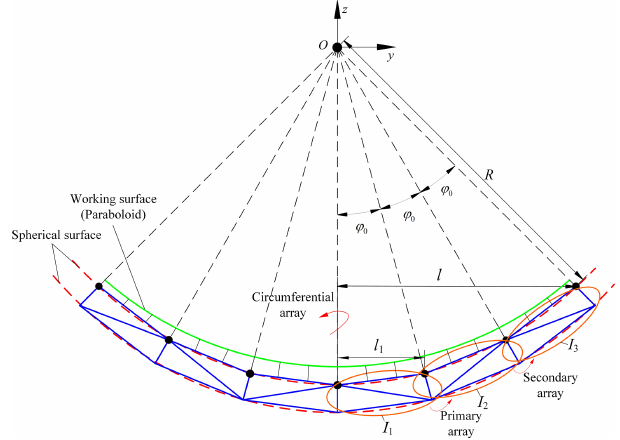
Figure 6. Schematic diagram of a rib-fitting sphere.